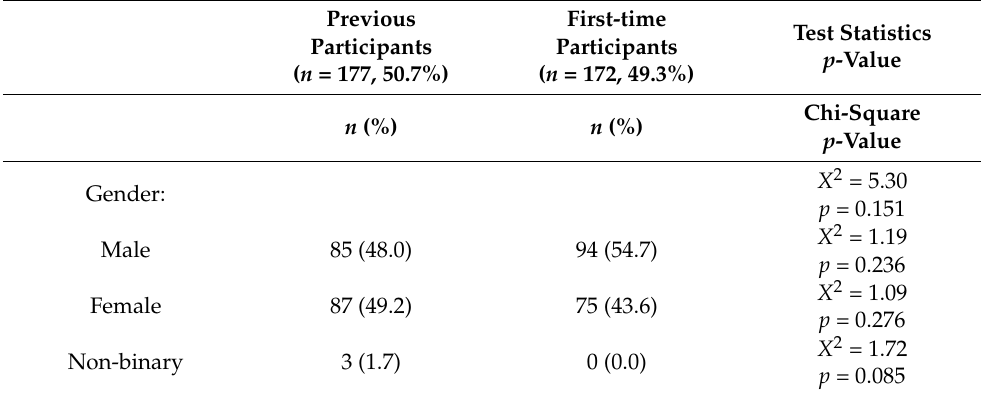
Table 1. Demographic Characteristics of Previous and First-time Participants ( n =